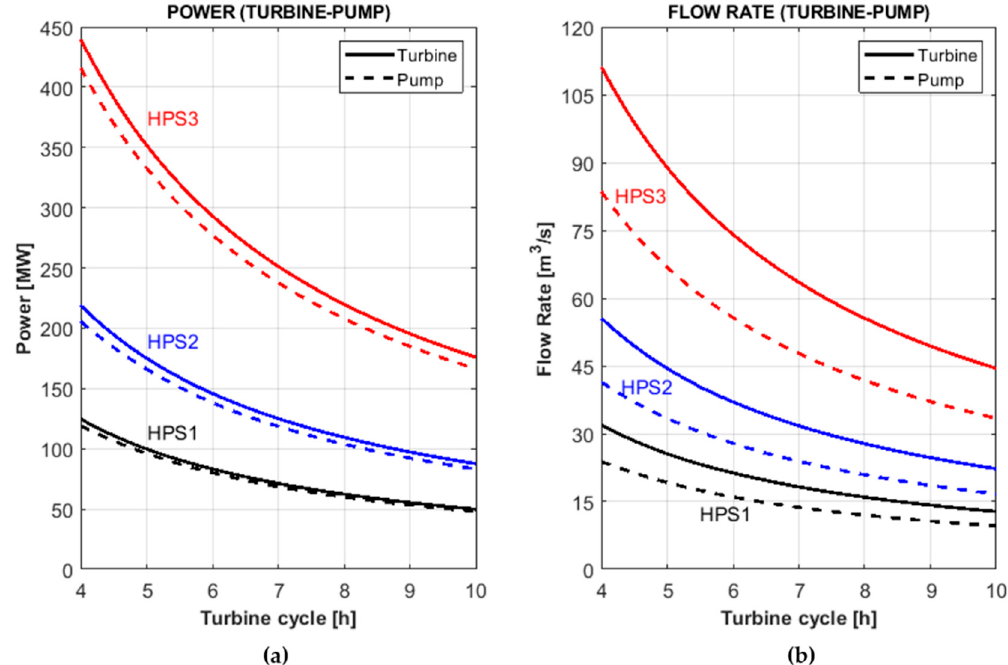
Figure 3. Technical data of HPS 1, HPS 2 and HPS 3, considering daily turbine cycle times at full load (DTCs) between 4–10 h day − 1 . ( a ) Power in turbine and pump modes; ( b ) water flow rate in turbine and pump modes.